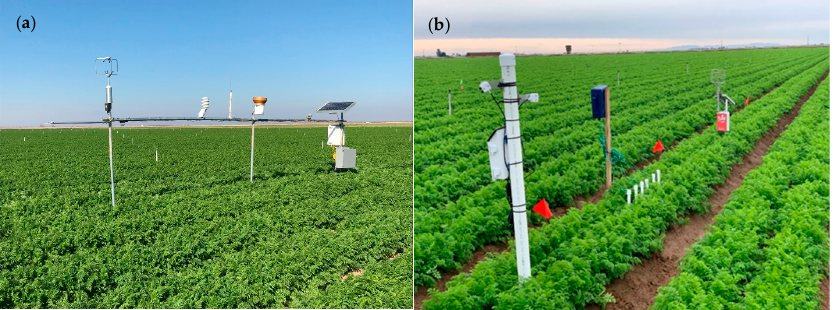
Figure 2. Monitoring stations: ( a ) A fully automated surface renewal and eddy covariance evapotranspiration (ET) tower at Site I, ( b ) multi-depth soil moisture sensor, along with a Tule sensor, at Site IX. Except for the soil sensors, all sensors were set up at 1.8 m above the ground surface. The data were recorded using a combination of a Campbell Scientific CR1000X data logger and a CDM-A116 analog input module. Direct two-way communication with each moni- toring flux tower was possible using a cellular phone modem (model CELL210, Campbell Scientific Inc., Logan, UT, USA). In addition, a Tule sensor (Tule Technologies Inc., Oakland, CA, USA) was installed